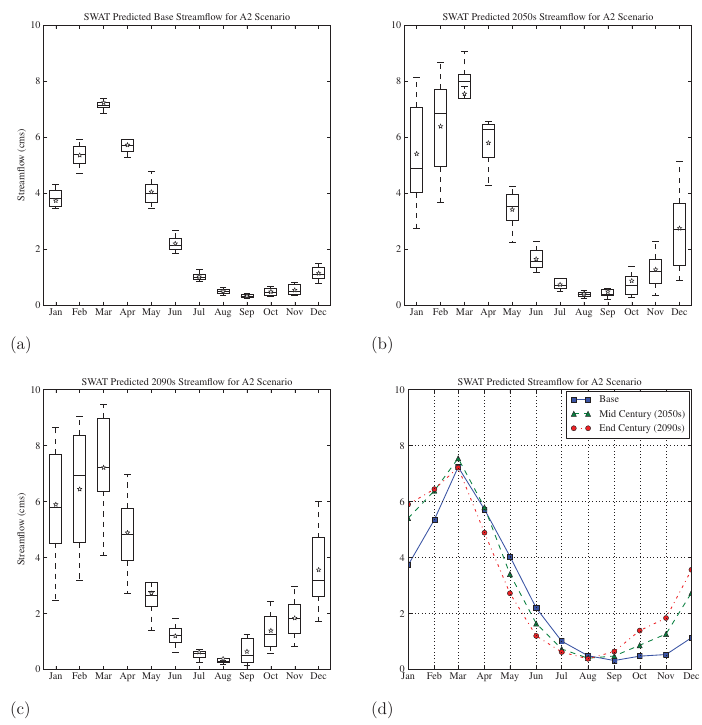
Figure 5. SWAT predicted monthly average streamflow. ( a ) Base period (1970–2000); ( b ) Mid − Century Figure 5.4: SWAT predicted monthly average streamflow. (a) Base period (1970- 2000); (b) Mid Century (2048-2065); (c) End Century (2085-2099); from 8 GCMs (2048–2065); ( c ) End − Century (2085–2099); from 8 GCMs predicted A2 emission scenarios at USGS predicted A2 emission scenarios at USGS station 02085070; (d) the average stream- station 02085070; ( d ) the average streamflow over the 8 GCMs for the three study periods. flow over the 8 GCMs for the three study periods. 12.1% (25.2 to -53.4%) by the end century from the base condition (87.14 kg N d − 1 ) across the models for the A2 scenarios. For the B1 scenario, these deceases are 9.5% (23.0 to -25.5%) and 8.5% (24.4 to -32.5%), respectively. This indicates that, even though the inorganic nitrogen loading for B1 scenario decreases by the mid century, the decrease will not continue to the end of the century. Model results